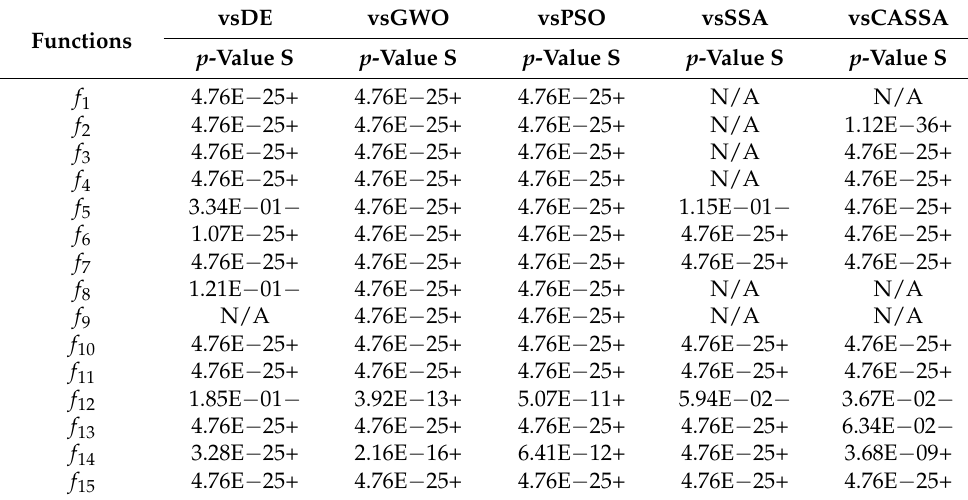
Table 5. p -value for Wilcoxon